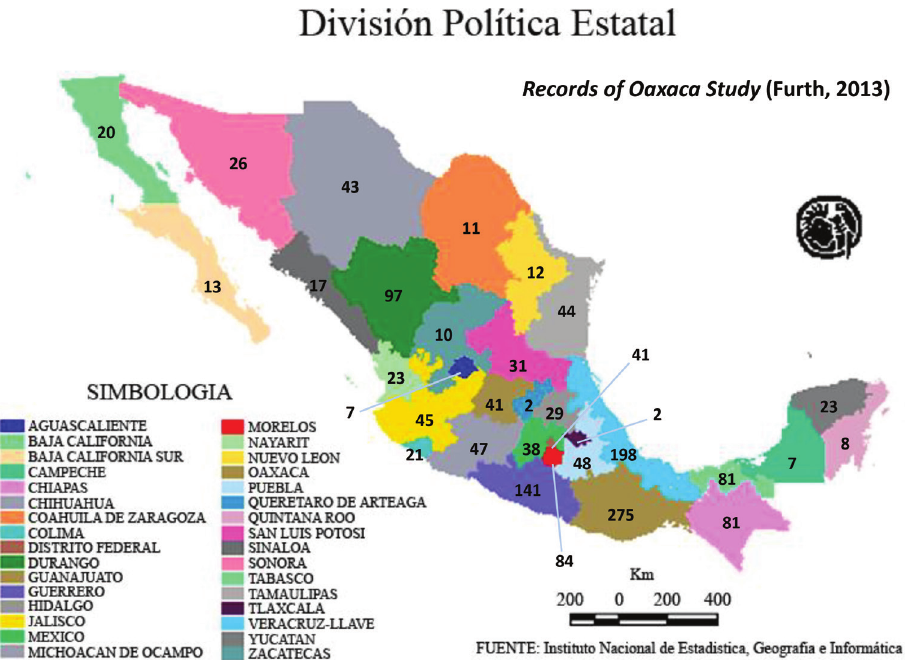
Map 1. Species numbers by states from Furth (2013).